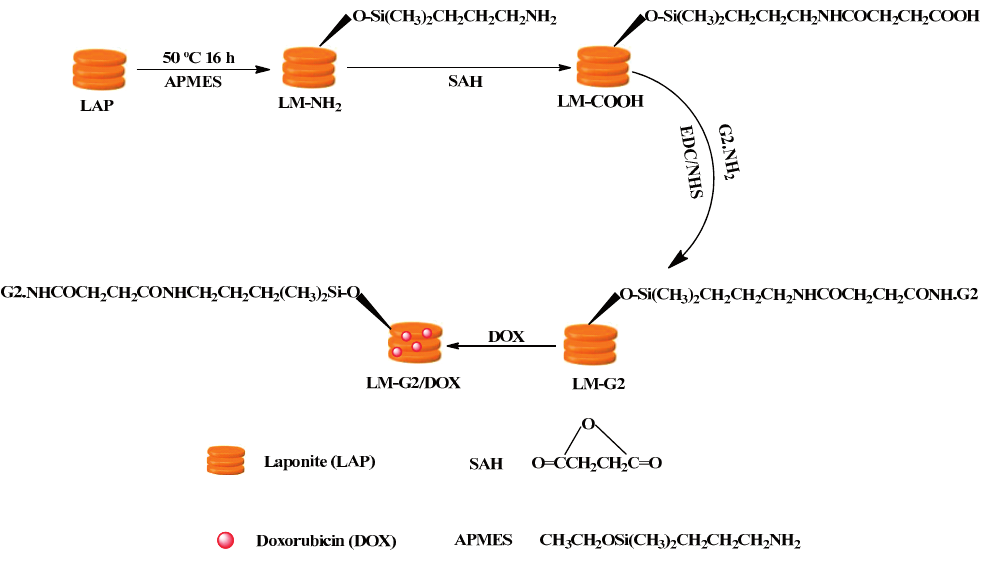
Figure 1. Schematic representation of the preparation of the formed dendrimer-modified LAP (LM-G2)/doxorubicin (DOX) complexes.